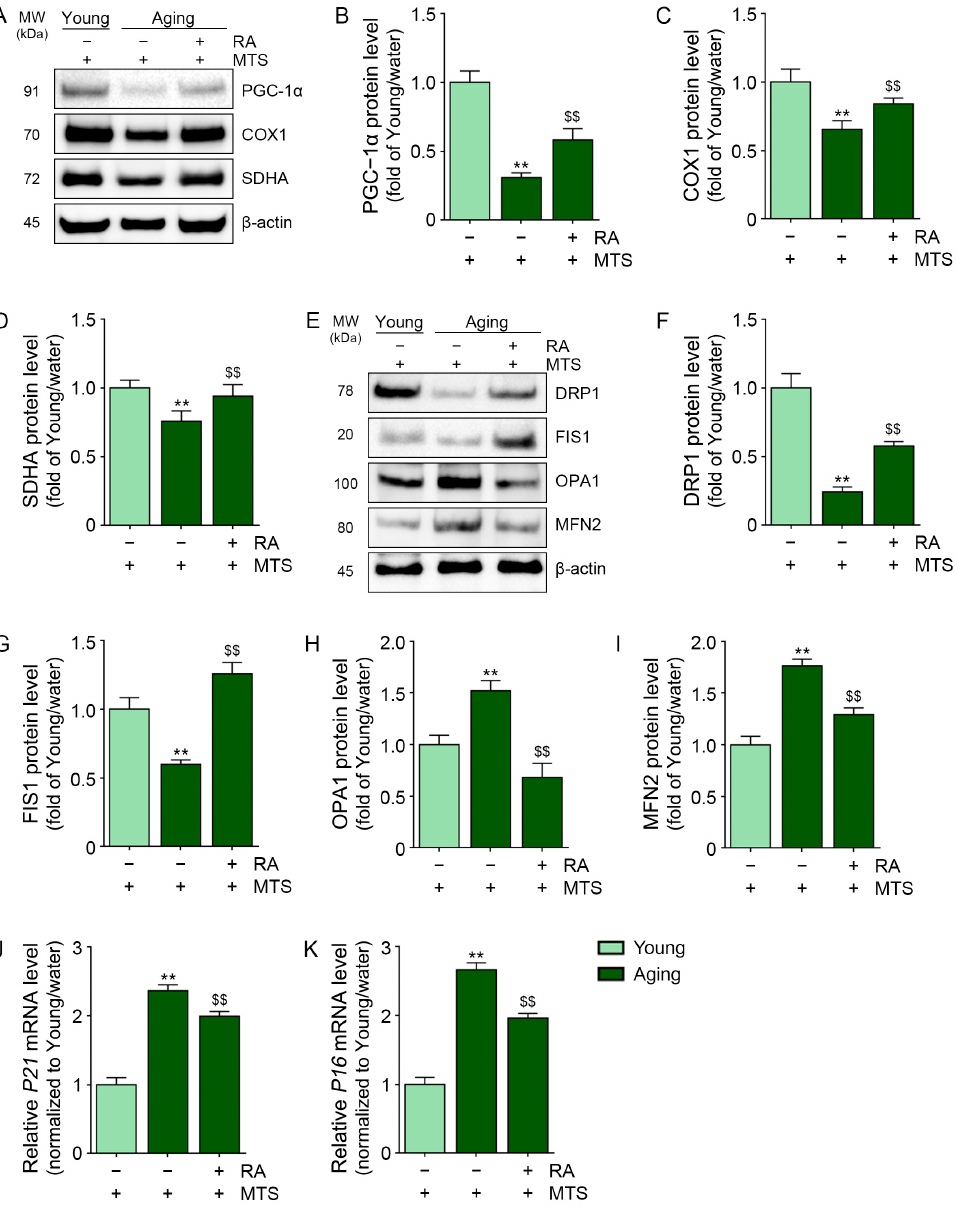
Figure 3. RA treatment decreased mitochondrial dysfunction and cellular senescence in aged mouse skin. ( A – I ) Mitochondrial dysfunction in aged mouse skin was confirmed by western blotting. The levels of the mitochondrial biogenesis markers PGC-1 α ( B ), COX1 ( C ), and SDHA ( E ) were decreased in aged mouse skin but increased by RA injection. The levels of the mitochondrial fission markers DRP1 ( F ) and FIS1 ( G ) were also decreased in aged mouse skin but increased by RA injection. The levels of the mitochondrial fusion markers OPA1 ( H ) and MFN2 ( I) were increased in aged mouse skin but decreased by RA injection. ( J , K ) Cellular senescence in aged mouse skin was con- firmed by qRT ‒ PCR. The levels of the cellular senescence markers P21 ( H ) and P16 ( I) were in- creased in aged skin but decreased by RA injection. The data are presented as the mean ± SD of three independent experiments. **, p < 0.01, second bar vs. first bar; $$, p < 0.01, third bar vs. second bar (Mann–Whitney U test). COX; cytochrome c oxidase, DRP1; dynamin-related protein 1, FIS1; mito- chondrial fission 1 protein, MFN2; mitofusin 2, MW; molecular weight, NA; niacinamide, OPA1; optic atrophy protein 1, PBS; phosphate-buffered saline, PGC-1 α ; peroxisome proliferator-activated receptor γ coactivator 1 α , SDHA; succinate dehydrogenase complex and flavoprotein subunit A. 3.3. RA Decreased NF- Κ b/AP-1 and MMP1/2/3/9 Expression in Aged Skin